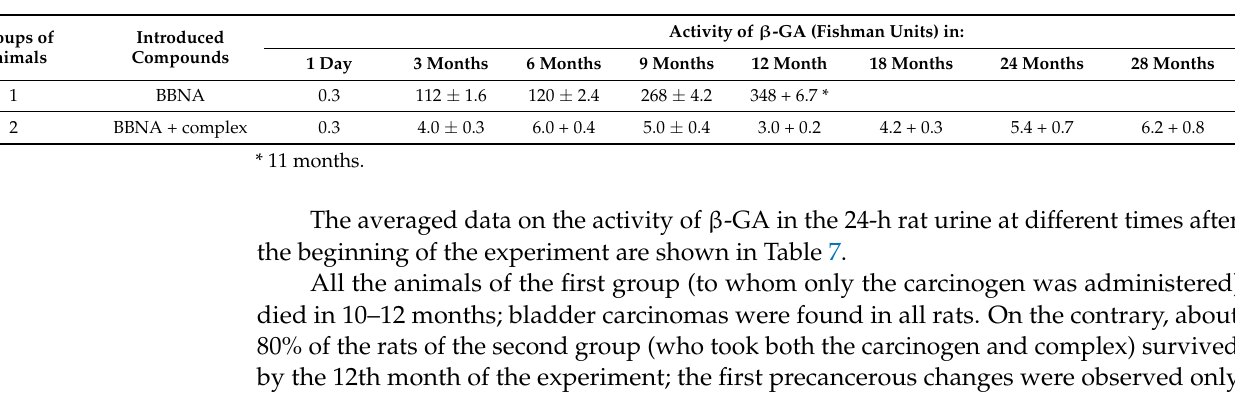
Table 7. Activity of β -GA in 24-h rat urine depending on duration of the experiment. Groups of Introduced Animals Compounds